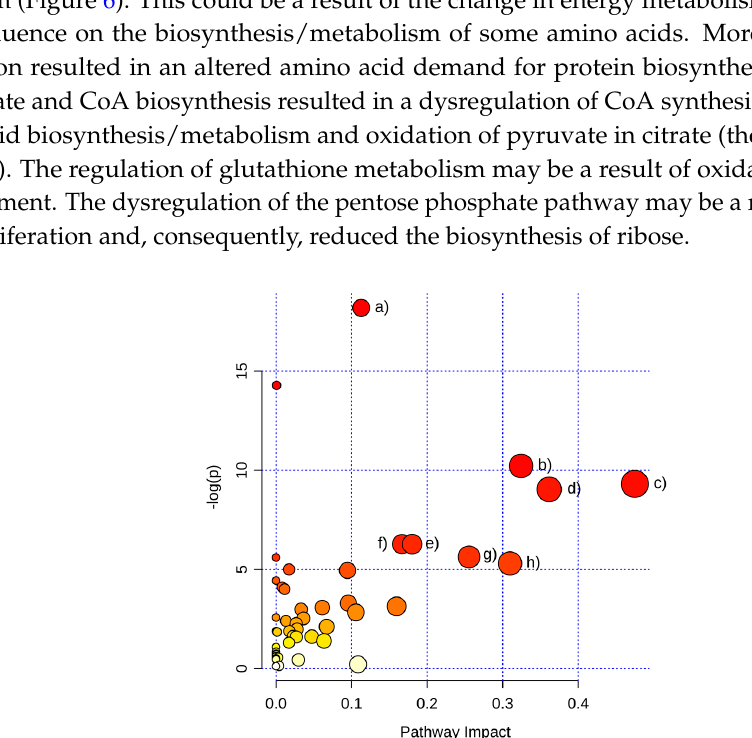
Figure 6. Map of pathway analysis shown in pathway impact and − log(p). Pathway impact is the